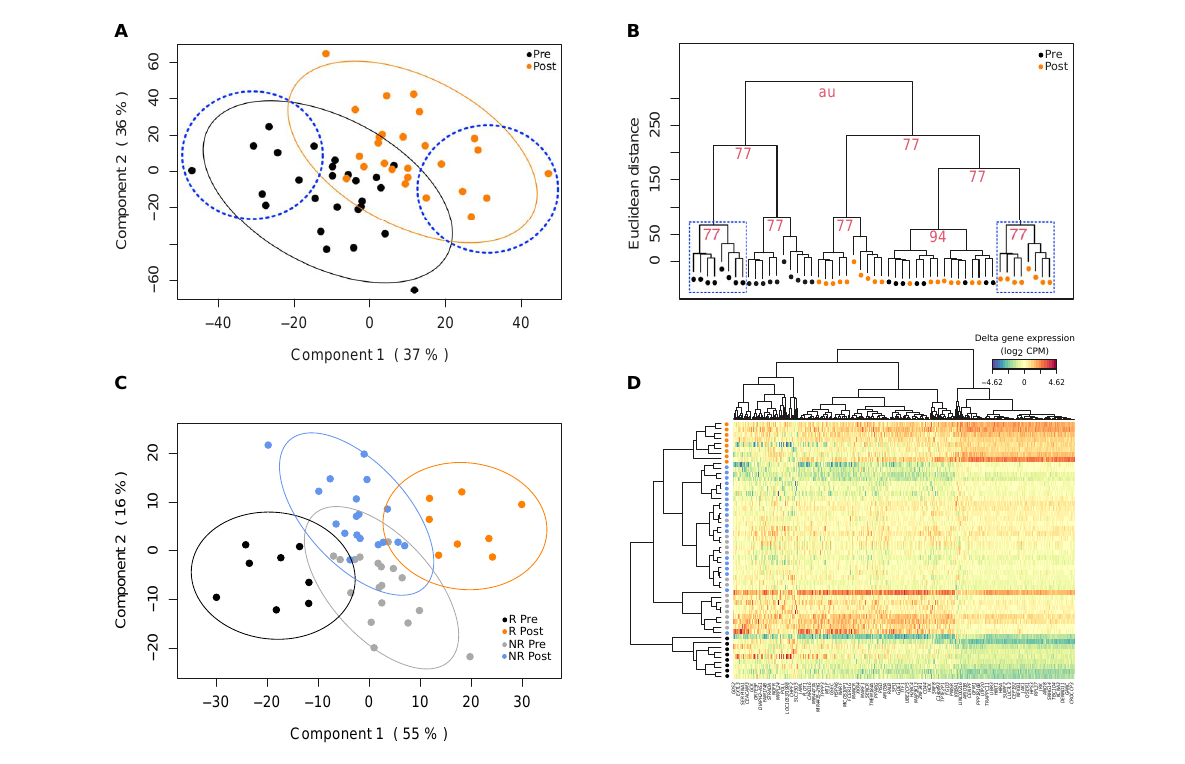
FIGURE1 Discriminant analysis and hierarchical clustering. (A) Projection of pre- and post-intervention visits (black and orange dots, respectively) of the ungrouped cohort onto the space, spanned by the two principal components derived from partial least-squares discriminant analysis (PLS-DA). The two first components of the model along with their corresponding explained variance are shown on x- and y-axis, respectively. Ellipses represent 95% confidence intervals around the centroid of each visit group. Blue dashed circles encompass participants into the newly sub-group of responders identified by hierarchical clustering analysis (HCA). (B) Dendrogram resulting from applying HCA (Ward’s method) on the two first components of PLS-DA. The Euclidean distance on the y-axis measures the dissimilarity between each pair of observations. Blue dashed squares encompass matched pre- (black dots) and post-mango consumption visits (orange dots) of participants from the so-called responder sub-group. Numbers represent approximately unbiased p -values (AU) for each cluster. (C) Results from multilevel sPLS-DA show the complete discrimination between pre- (black dots) and post- visits (orange dots) in the responder (R) group. In the non-responder group (NR), pre- (gray dots) and post- visits (blue dots) are mixed. The two first components of the sPLS-DA accounted for 55% and 16%, and were composed of 230 and 460 genes, respectively. (D) The heatmap shows group classification (26 matched-pairs in rows) based on the two main sPLS-DA components (genes in columns). Within the group of responders, pre- (black dots) and post-mango consumption visits (orange dots) are clearly separated on the top and bottom rows of the